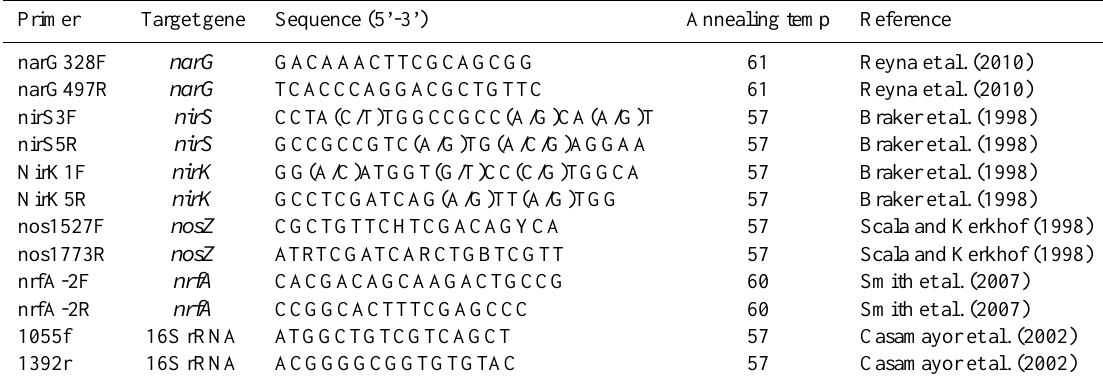
Table 2. Real time PCR primers used for the amplification of denitrifying